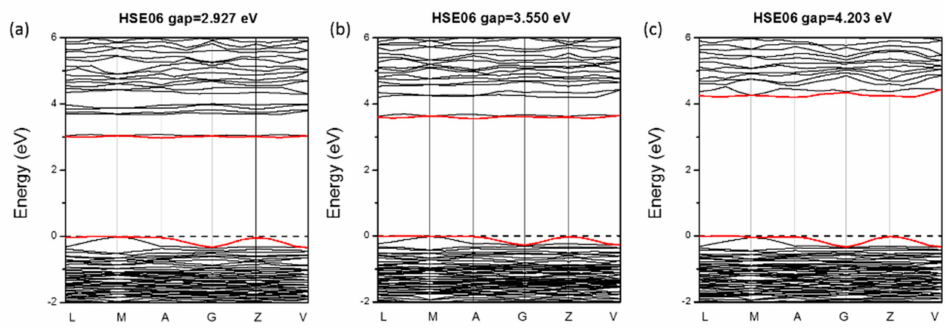
Figure 3. The band structures of BaMO(IO 3 ) 5 . ( a ) BaVO(IO 3 ) 5 ; ( b ) BaNbO(IO 3 ) 5 ; ( c ) BaTaO(IO 3 ) 5 . The Fermi level is set at 0 eV; the red lines denote the VBM and